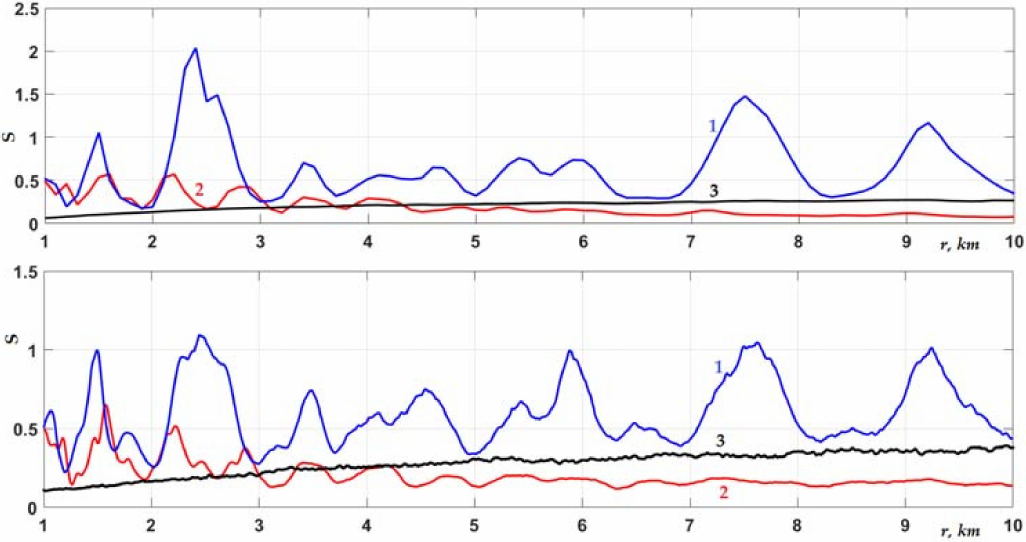
Figure 12. S-behavior of a signal of 500 Hz in a waveguide with fluctuations δ h . (cid:104) c 1 (cid:105) = 1500 m/s, δ c 1 = 0. Top graph corresponds to L h = 1 km; curves: 1 is OW solution, z = z 0 = 36 m, 2 is for z = z 0 = 24 m, 3 is noncoherent sum of modes for z = z 0 = 36 m. Lower graph shows similar (to top graph) curves for L h = 100